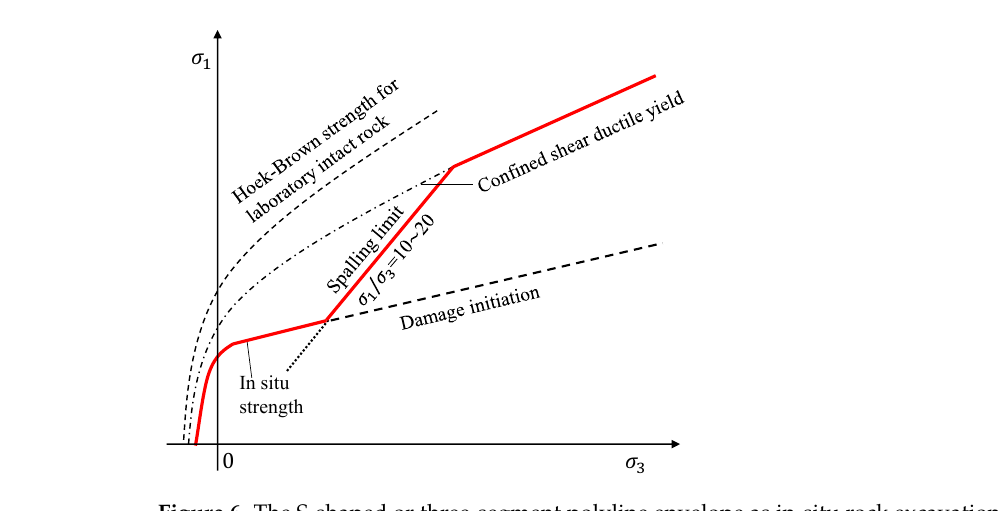
Figure 6. The S-shaped or three-segment polyline envelope as in-situ rock excavation strength [39].